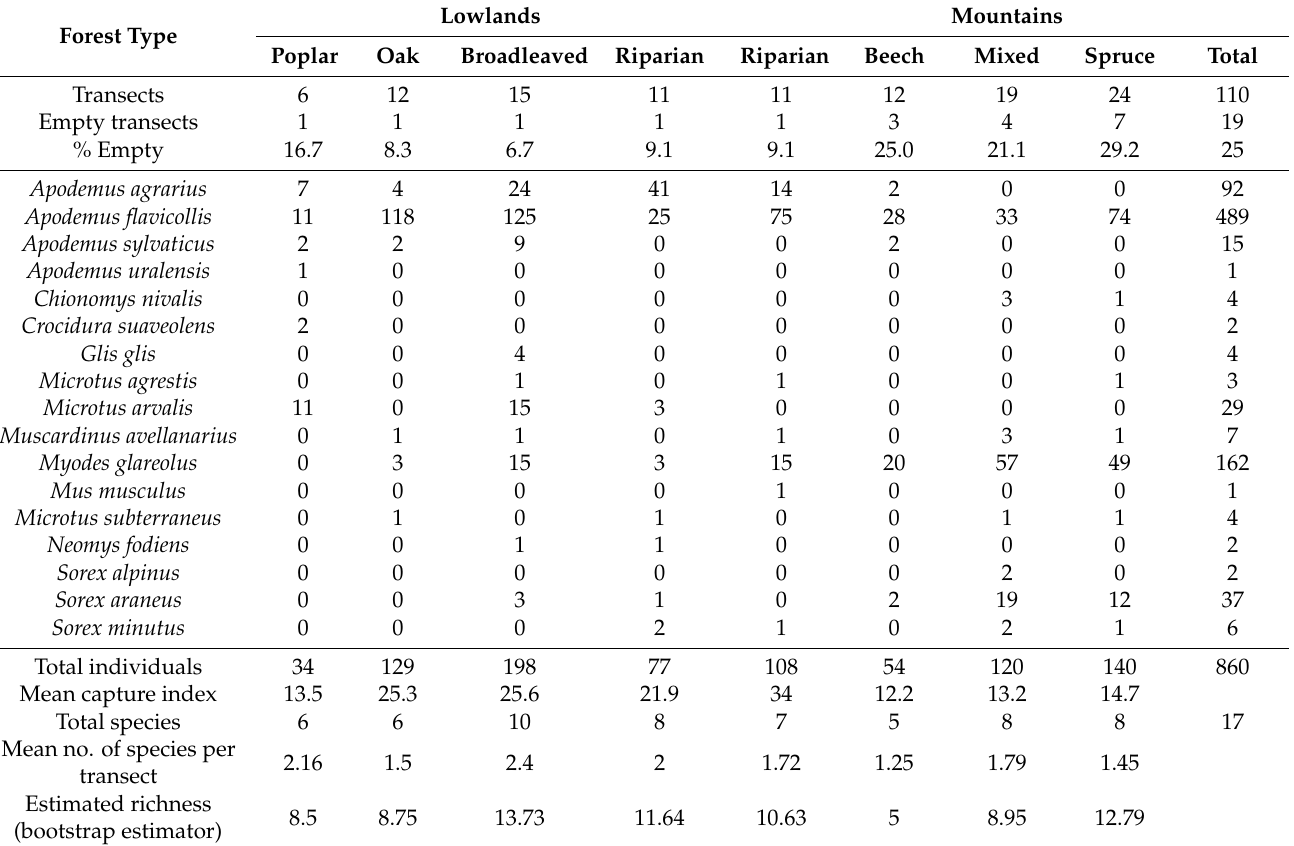
Table 1. Results of small mammal trapping in the selected transects of the eight surveyed forest types, with no temporal